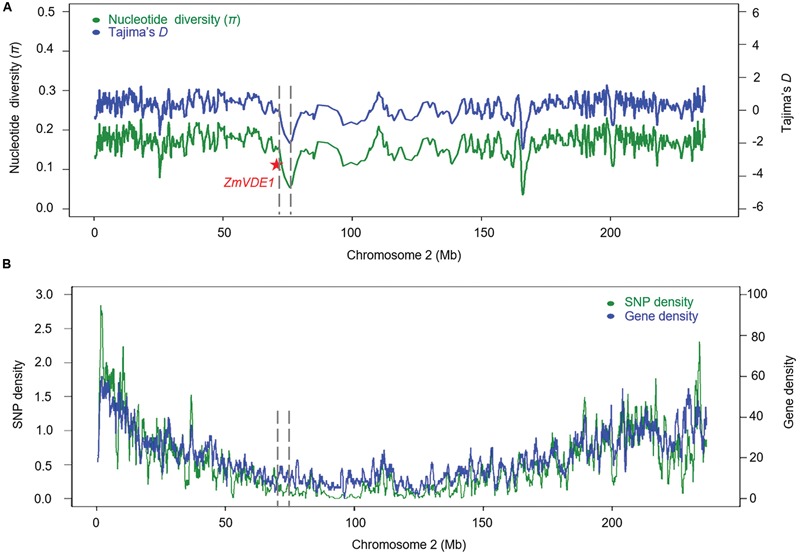
Nucleotide variation on chromosome 2 in 368 maize inbred lines. (A) Nucleotide diversity (π) and Tajima’s D for maize chromosome 2. The red star represents ZmVDE1. The dash line represents the selection sweep region of 4.2 Mb. (B) SNP density (green) and gene density (blue) calculated using a 1 Mb sliding window with a 100-kb step.